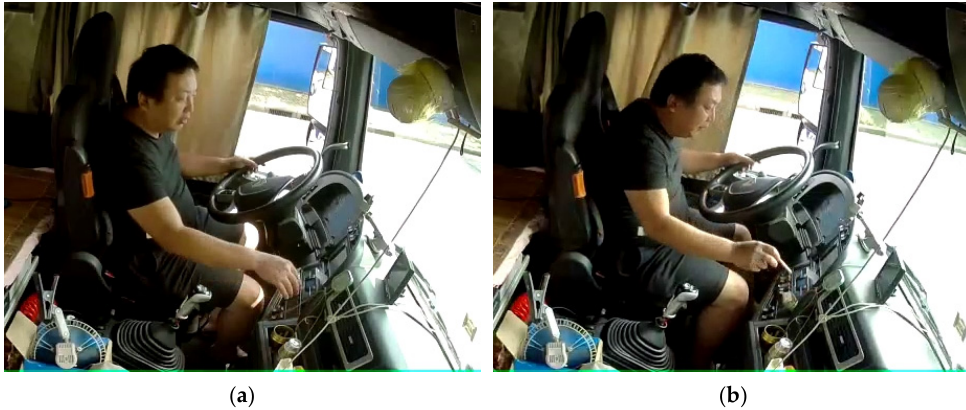
Figure 3. Similarity of commercial vehicle driver postures: ( a ) controlling the dashboard; ( b ) taking things.